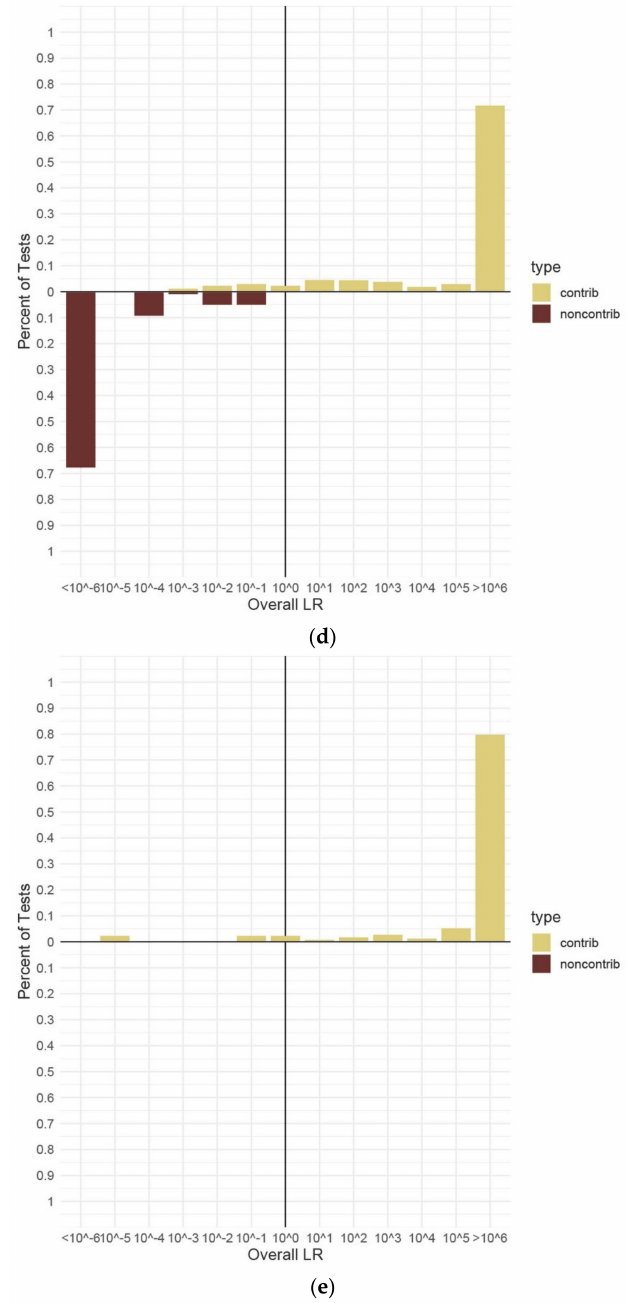
Figure 4. Percentage of overall (sub-sub-source) LRs for true contributors and non-contributors. ( a ). Two-person mixtures. ( b ). Three-person mixtures. ( c ). Four-person mixtures. ( d ). Five-person mixture € ( e ). Three-person mixtures conditioned with defined known contributor. Panel ( a ) shows two-person data from 300 H 1 true and 40 H 2 true tests with no conditioning knowns. Panel ( b ) shows three-person data from 538 H 1 true and 90 H 2 true tests with no conditioning knowns. Panel ( c ) shows four-person data from 420 H 1 true and 60 H 2 true tests with no conditioning knowns. Panel ( d ) shows five-person data from 730 H 1 true and 95 H 2 true tests with no conditioning knowns. € el ( e ) shows three-person data from 200 H 1 true tests with a conditioning known identified. All data are from in vitro DNA samples analyzed using the range of hypotheses listed in Table 3 and the maximum number of MCMC iterations for the number of contributors. An LR value of ≥ 10 6 represents “Very Strong Support” on the verbal scale [47], and so, all results meeting this threshold were combined on the